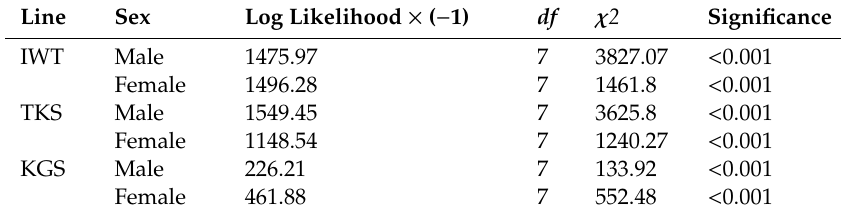
Table 5. Likelihood ratio tests using a refined ordered logistic regression model for maturation of male and female gametophytes at Iwate (IWT), Tokushima (TKS), and Kagoshima (KGS).